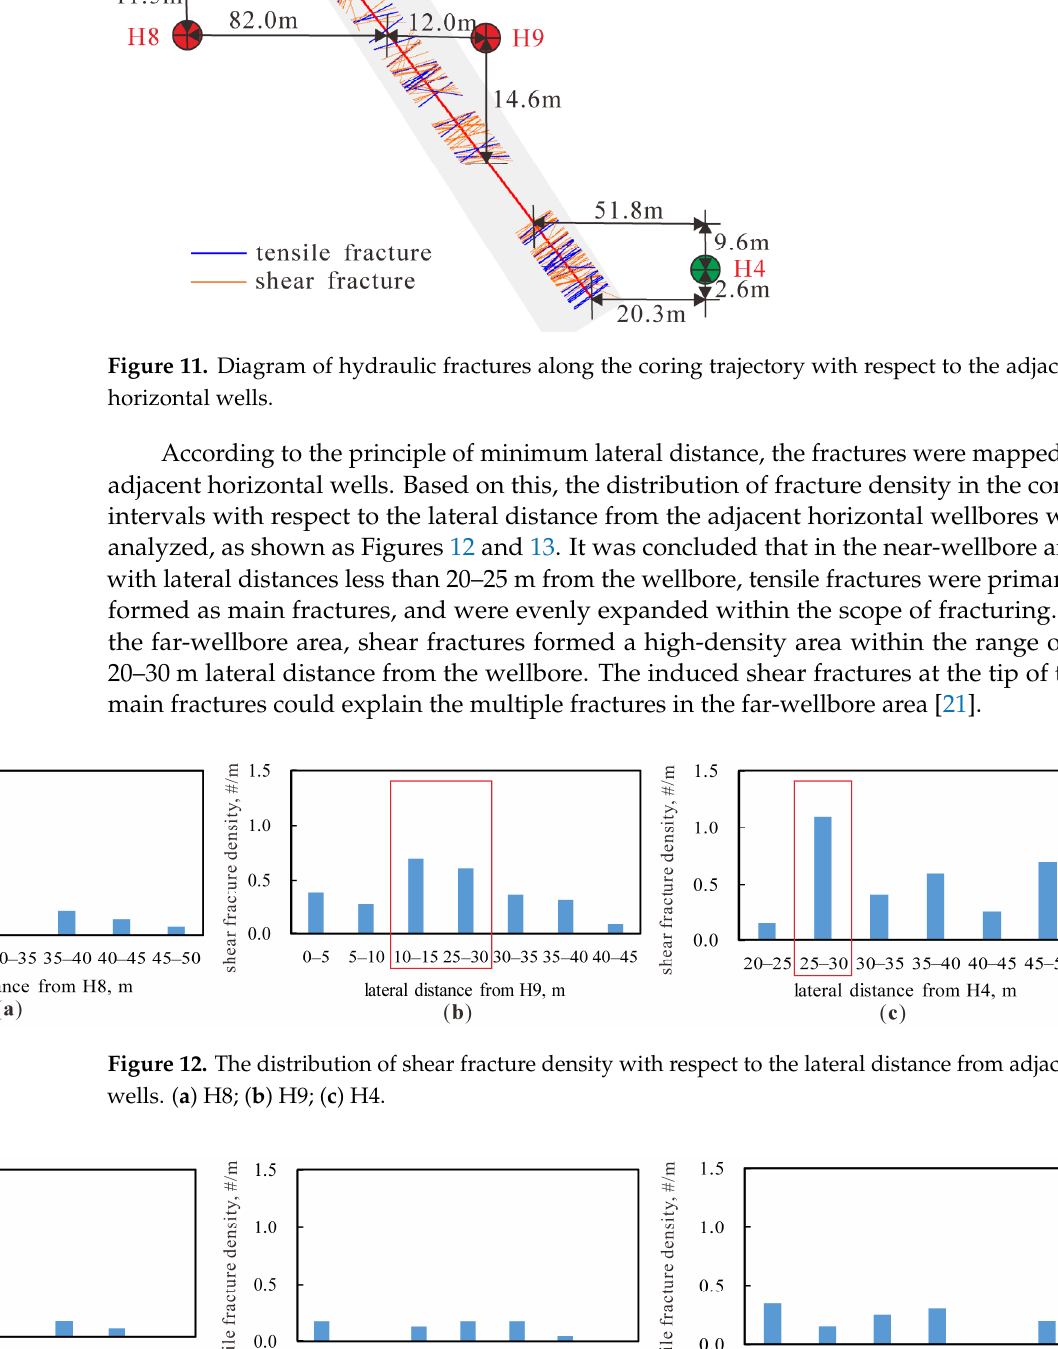
Figure 10. Core fractures along the coring trajectory.